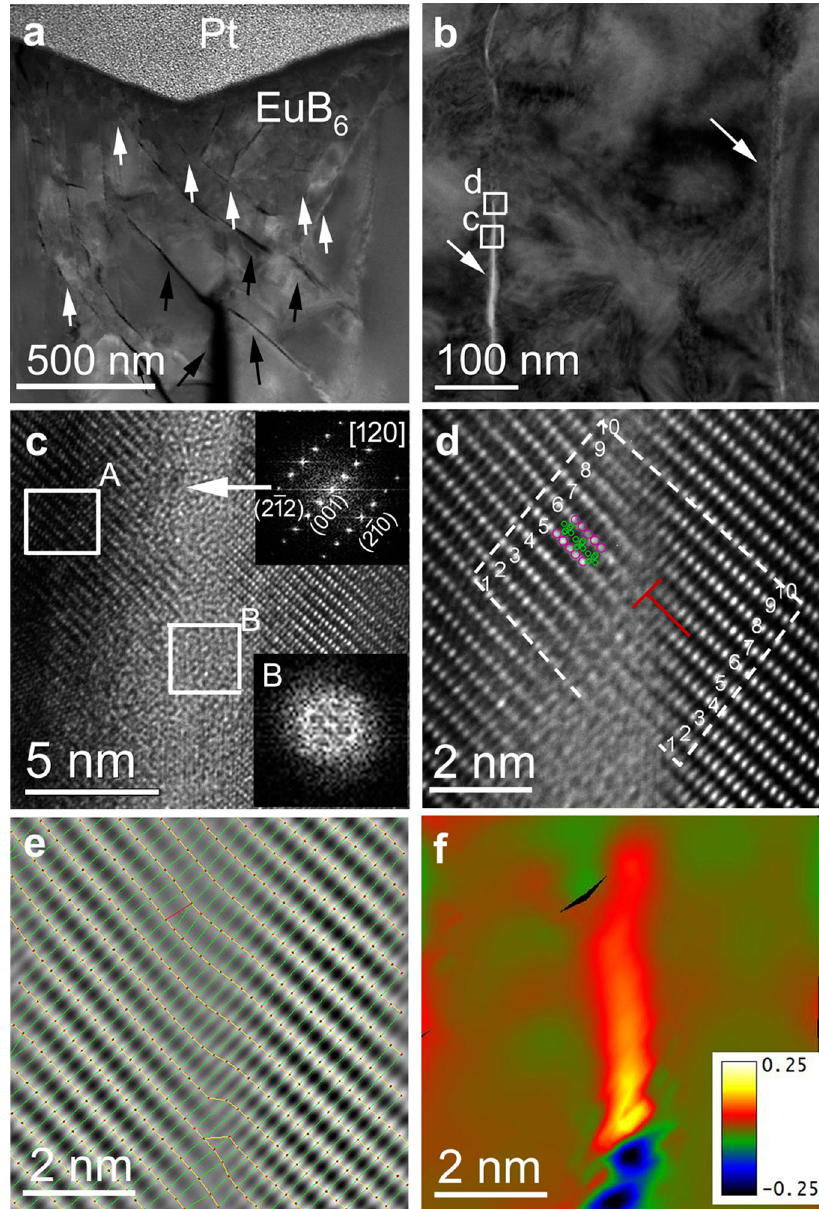
Fig. 3 TEM observations underneath the indent region along [100] orientation of EuB 6 . a Low magni fi cation HAADF-STEM image of indent region shows microcracks and shear bands indicated by black and white arrows. b Magni fi ed TEM image of shear bands with a length of ~300 nm. c High magni fi cation TEM image shows the amorphous structure of the shear band with a width of 3 nm along the ð 2 (cid:1) 12 Þ plane. The FFT pattern of region A shows the crystallographic direction along [120] direction and FFT pattern of region B demonstrate amorphous nature with diffuse halo ring of the shear band. d HRTEM image at the tip of the shear band shows emission of dislocations. The atomic overlay of Eu and B atoms on HRTEM shows a unit cell of EuB 6 in which atomic colors are consistent with Fig. 1. e Grid obtained by Peak Pair Analysis from the image shown in d . f shear strain ( ε xy ) map obtained from same region of e